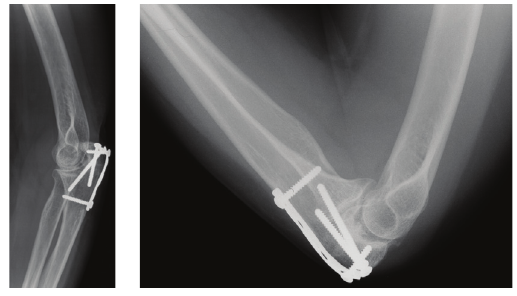
Figure 3: An iliac-crest bone graft, 6mm by 15 mm in size, was interposed to widen and reconstruct the trochlear notch. After lengthening of the proximal olecranon, the humerus could be easily reduced to restore ulnohumeral congruency. Stable fixation was achieved with 2 lag screws secured with a 4-hole LCP